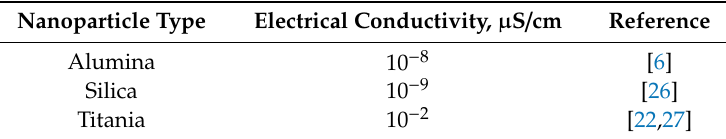
Table 1. Electrical conductivity of nanoparticles.